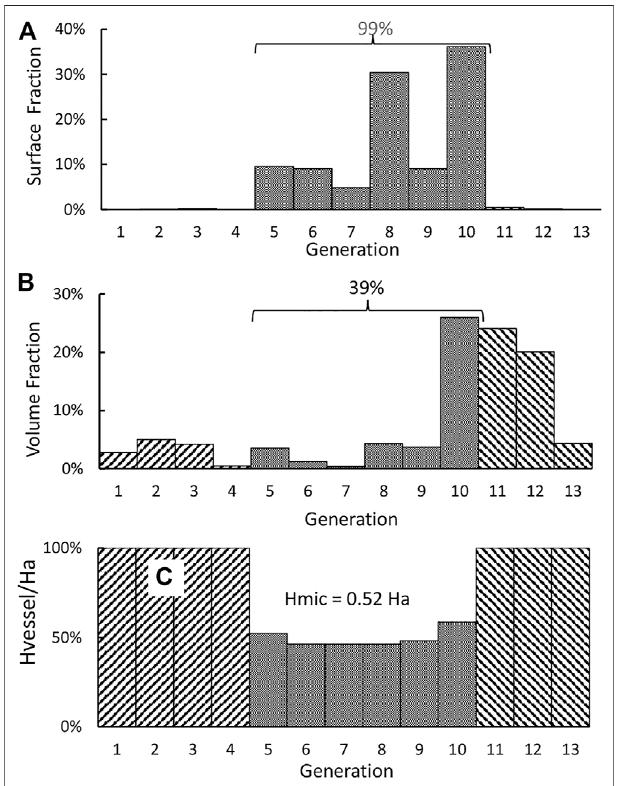
FIGURE 1 | (A) Distribution of the surface fraction of a 13-generation central vascular tree. (B) Distribution of the volume fraction. (C) Distribution of the hematocrit ratio Hvessel/Ha.